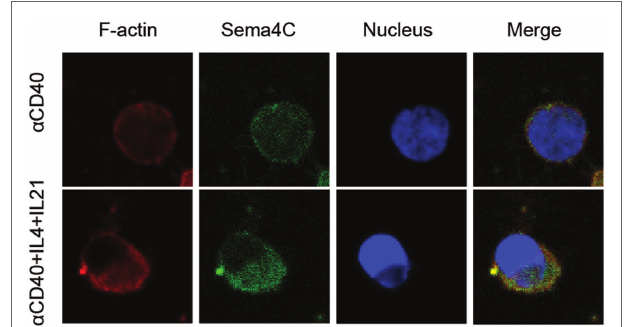
FigUre 5 | human sema4c associates with F-actin on activated B-cells . Human B-cells were isolated from tonsils and stimulated with anti-CD40 antibodies ± IL-4 and IL-21 for 5 days in slide chambers. Cells were stained with anti-F-actin antibodies (red), anti-human Sema4C antibodies (green), and a nuclear stain (Hoechst 33342, blue). Upper panel: CD40 antibodies; lower panel: CD40 antibodies + IL-4 + IL-21. Sema4C expression and organization into a synapse-like structure is optimally achieved with anti-CD40 + IL-4 + IL-21 but not with anti-CD40 alone. Representative images of three independent